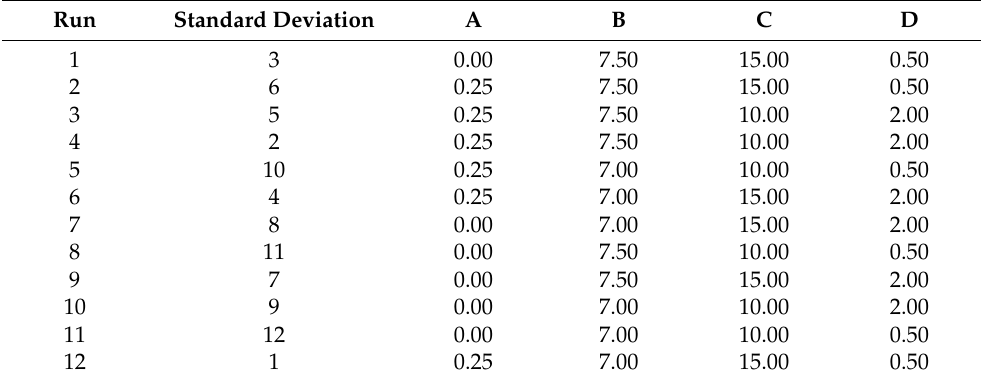
Table 1. Plackett–Burman experimental design for biosurfactant production by WCO and PCO using BS14 bacterial